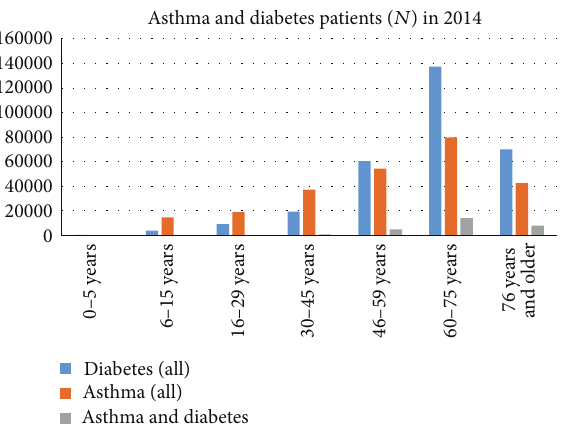
Figure 3: Number and distribution of asthma and diabetes patients according to